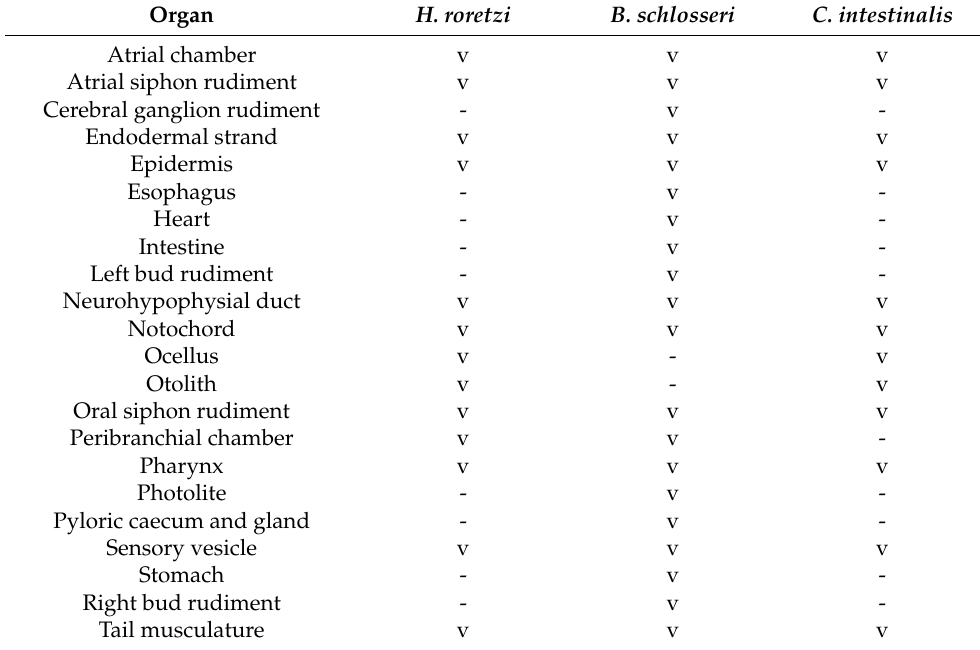
Table 1. List of anatomical structures represented in the 3D reconstructions of the three selected species. v: present; -: